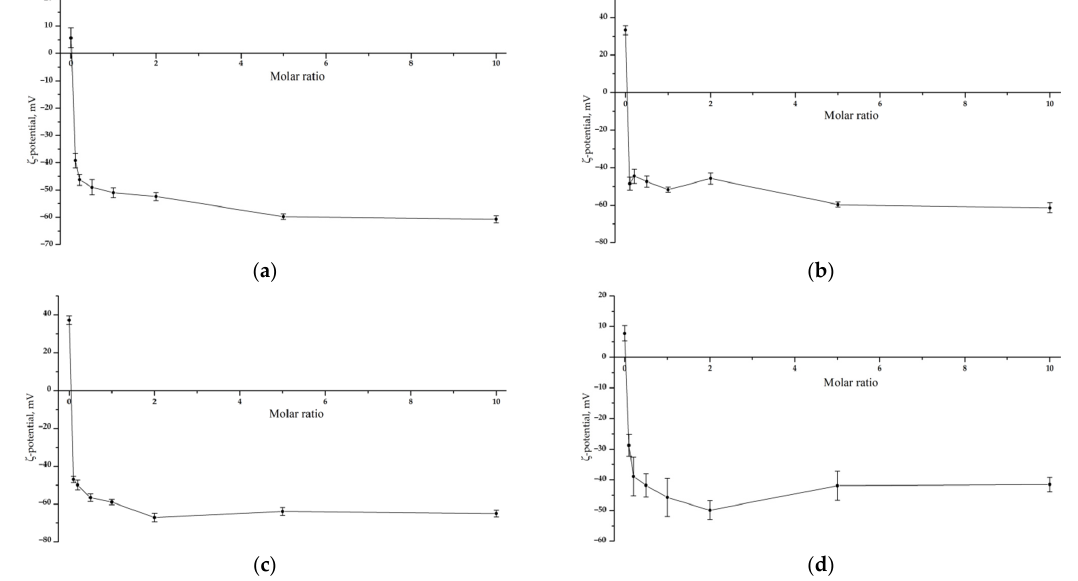
Figure 4. Dependences of the zeta-potential on the molar ratio of pillar[5]arene 5 /meroterpenoids 3a-d , ( a )— 5/3a , ( b )— 5/3b , ( c )— 5/3c , ( d )— 5/3d .